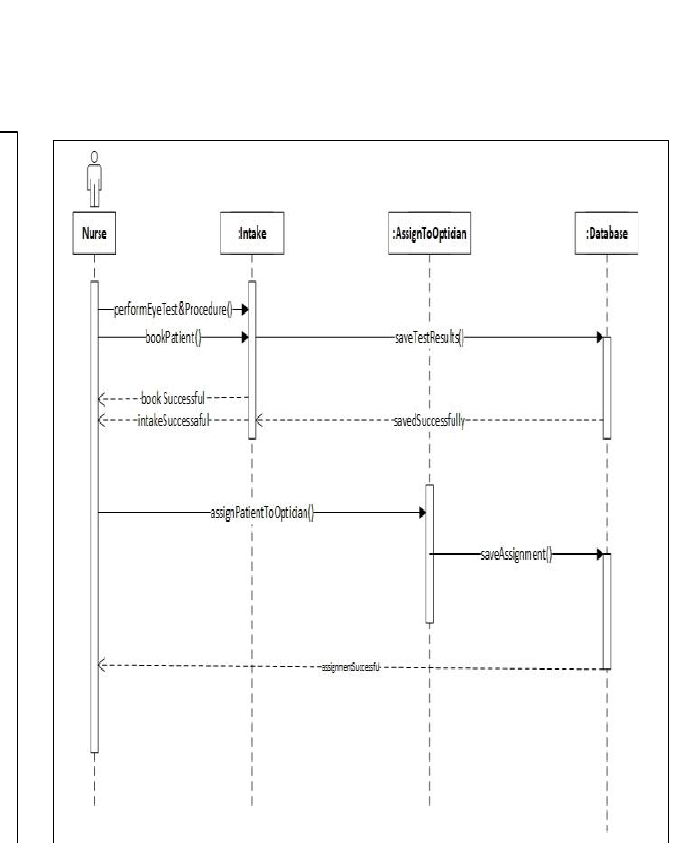
Figure 9. Nurse Sequence Diagram